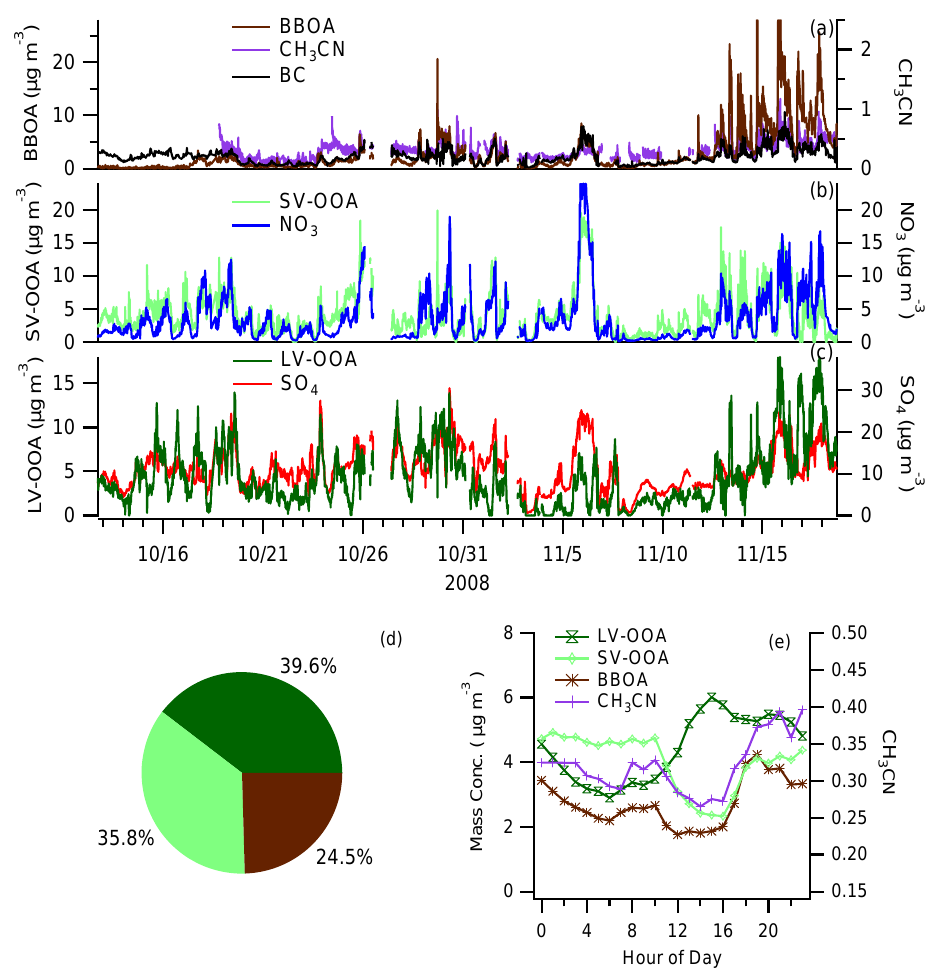
Fig. 6. Time series of (a–c) the OA components and other relevant species; (d) the average OA composition; and (e) the diurnal variations of the OA components and acetonitrile.